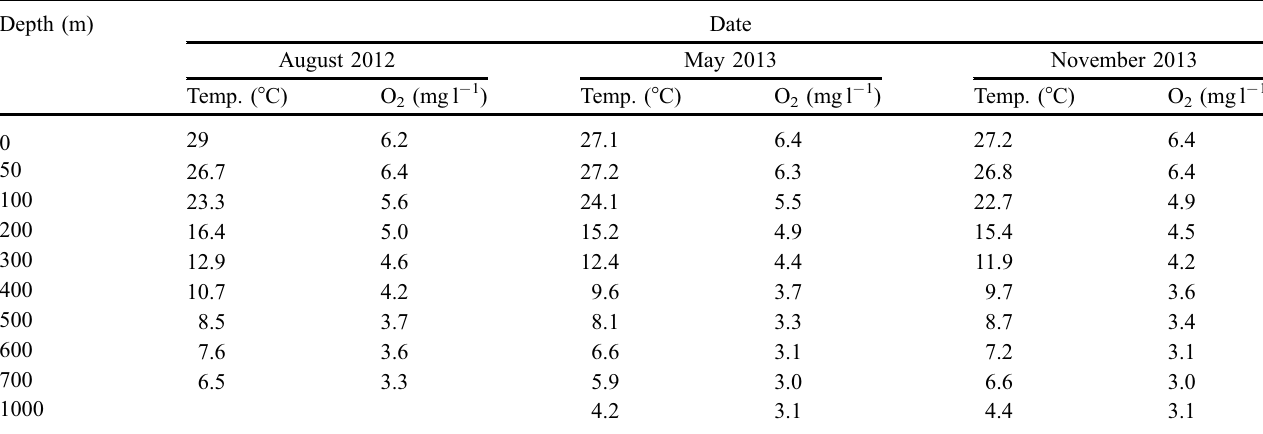
Table 4. Vertical pro fi le of waters temperature, depth and oxygen recorded using CTD in the same area as the tagged fi sh were released (22 ° 12 0 N; 119 ° 36.2 0 E) from August 2012 to November 2013. Depth